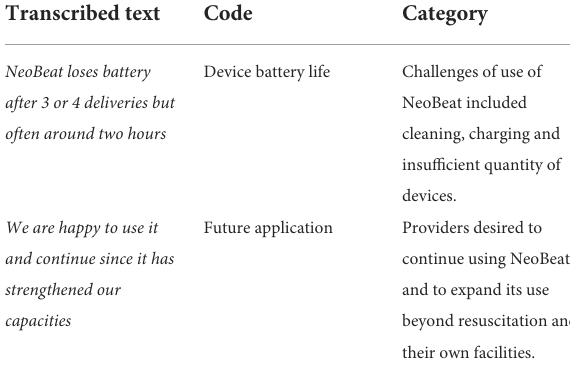
TABLE 1 Illustration of qualitative content analysis with examples of transcribed text, assigned code and